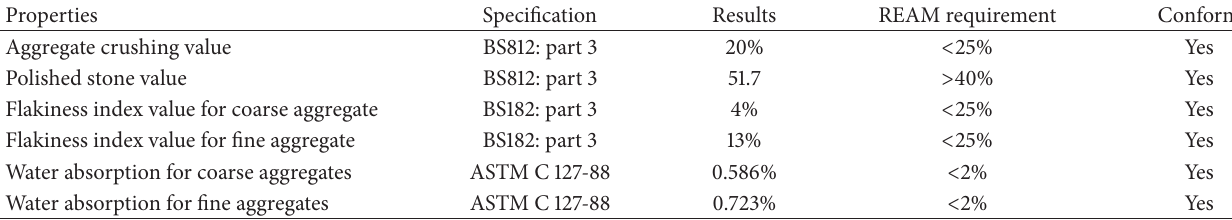
Table 1: Properties of crushed granite aggregate used in this